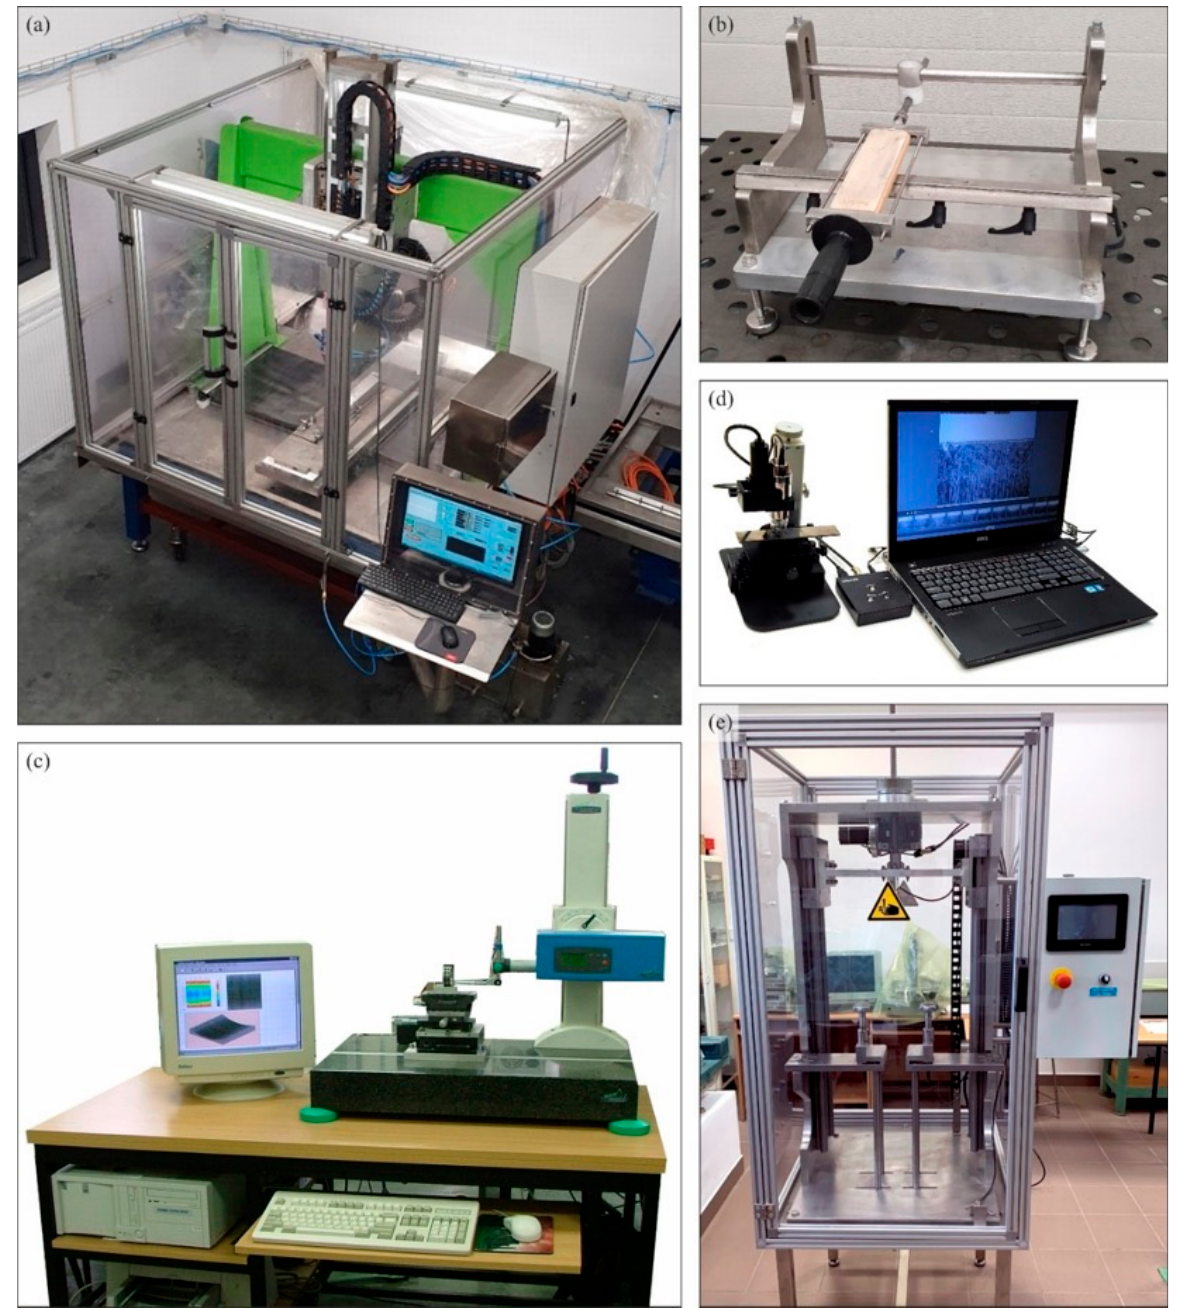
Figure 1. Test and measurement stands used in the described research: ( a ) five-axis CNC special grinder for sharpening technical blades; ( b ) special device for removing rewind from the blade after grinding; ( c ) position for contact measurements of surface texture equipped with a stylus profilometer Hommel-Tester T8000 by Hommelwerke GmbH, Villingen-Schwenningen, Germany [38]; ( d ) digital measuring microscope Dino-Lite Edge AM7515MT8A, AnMo Electronics Corporation, New Taipei City, Taiwan, China [39–41]; ( e ) special test stand for cutting force measurement.